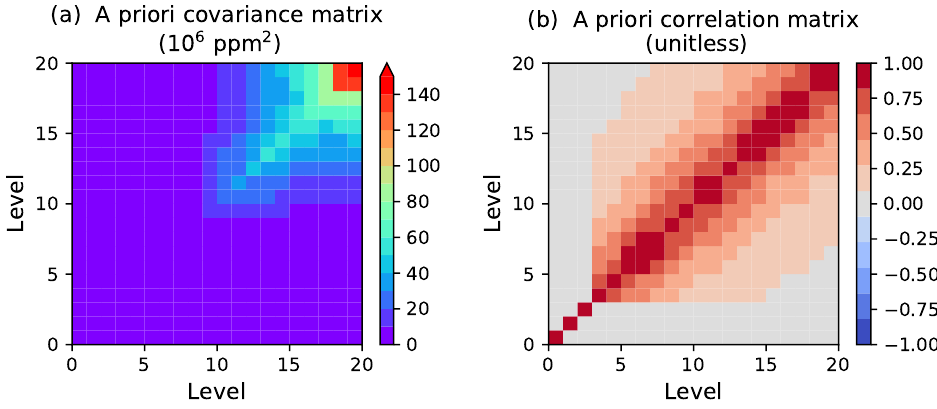
Figure 3. Water vapour prior covariance matrix ( a ) with the corresponding correlation matrix ( b ). The effect of zero correlation length in stratospheric levels can be seen in panel ( b ), were they are represented by grey